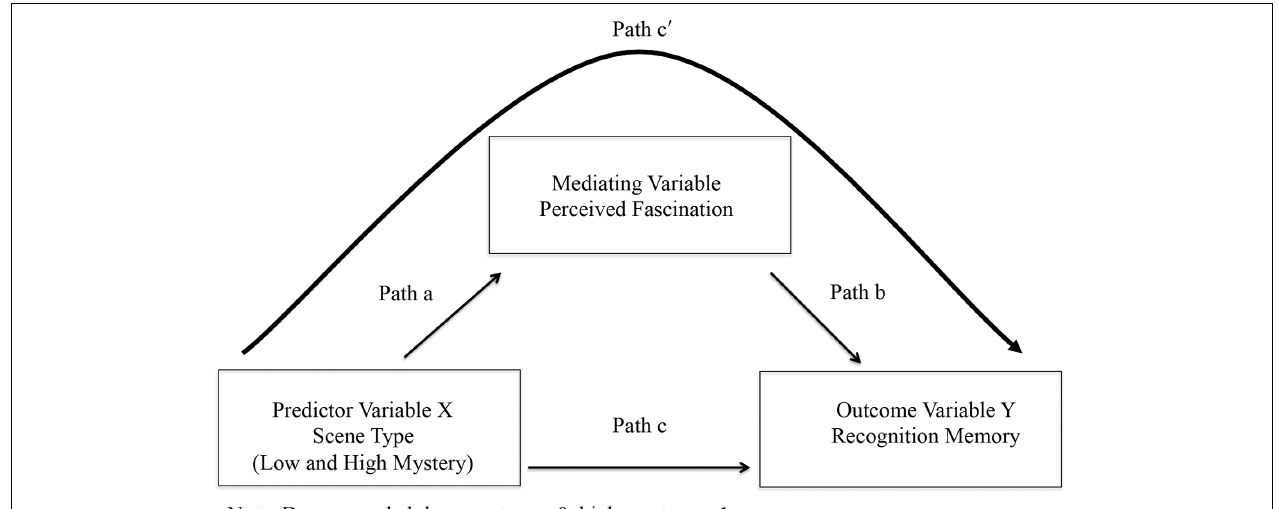
FIGURE 1 | Diagram of complete mediation